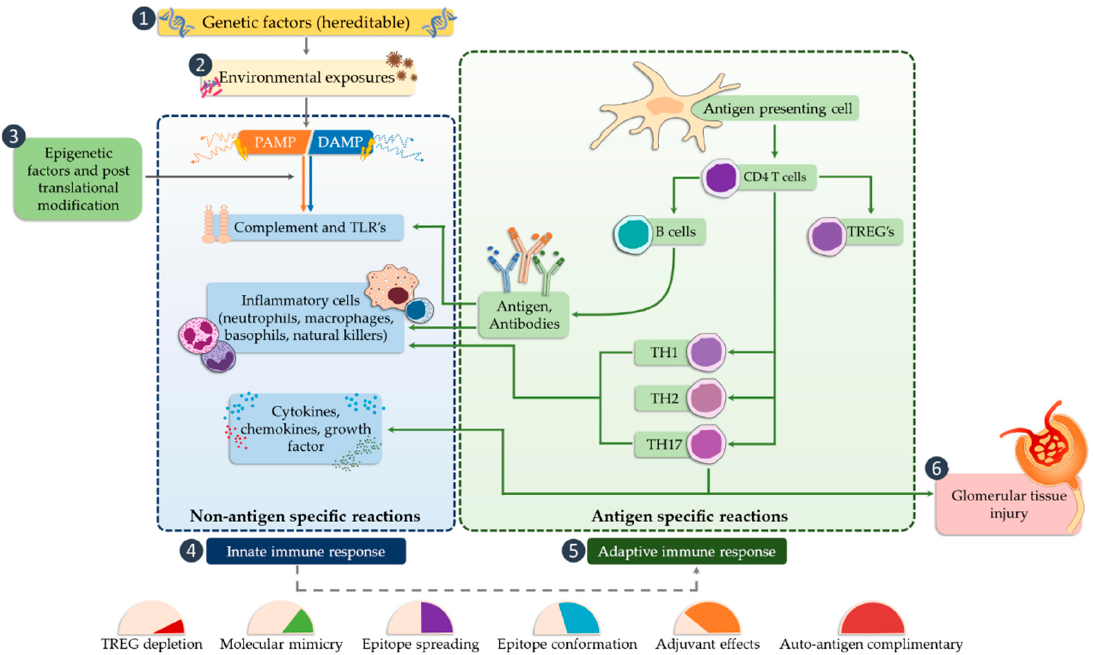
Figure 4. The potential occurrence of TLR receptors within the nephron (modified, based on